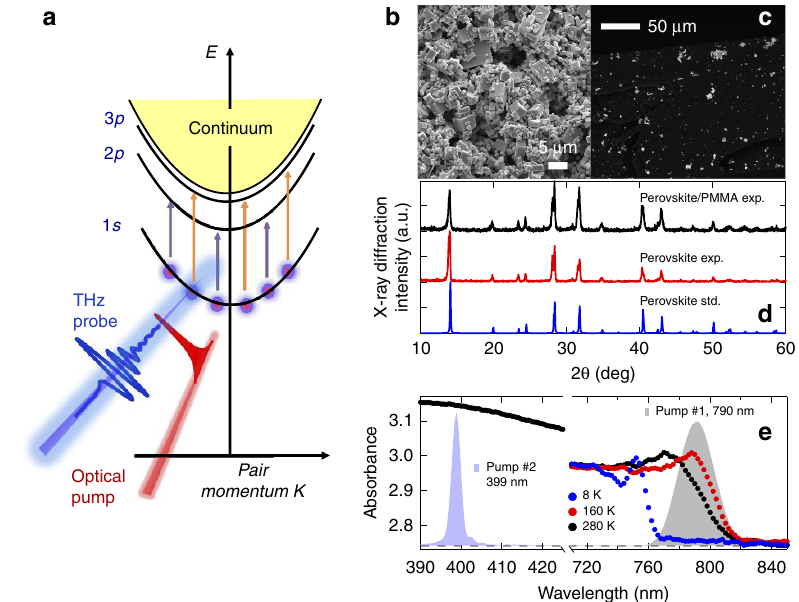
Figure 1 | THz conductivity measurement scheme and sample characterizations. ( a ) Schematics of exciton dispersion near K E 0, with internal quantum transitions of 1 s - 2 p and 1 s - 3 p marked. Photoexcitation creates pair transitions in the perovskites that are resonantly probed by THz pulses. ( b , c ) SEM images of pure CH 3 NH 3 PbI 3 powder and CH 3 NH 3 PbI 3 /PMMA film, respectively. ( d ) X-ray diffraction measurement of perovskite film and powder. ( e ) Absorption spectra of the perovskite/PMMA film at various temperatures. Shown together are the two pump spectra (#1 and #2,